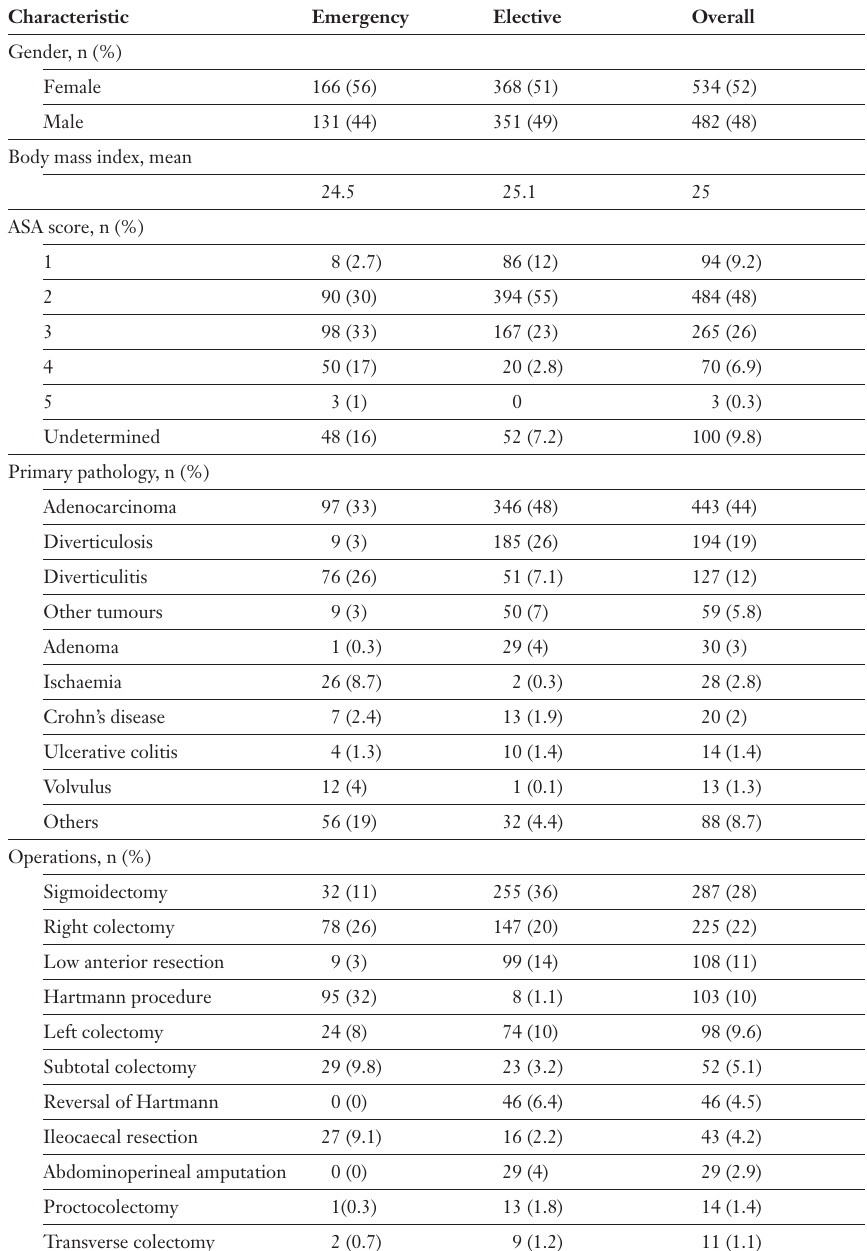
Table 2 Clinicopathological characteristics of pa-